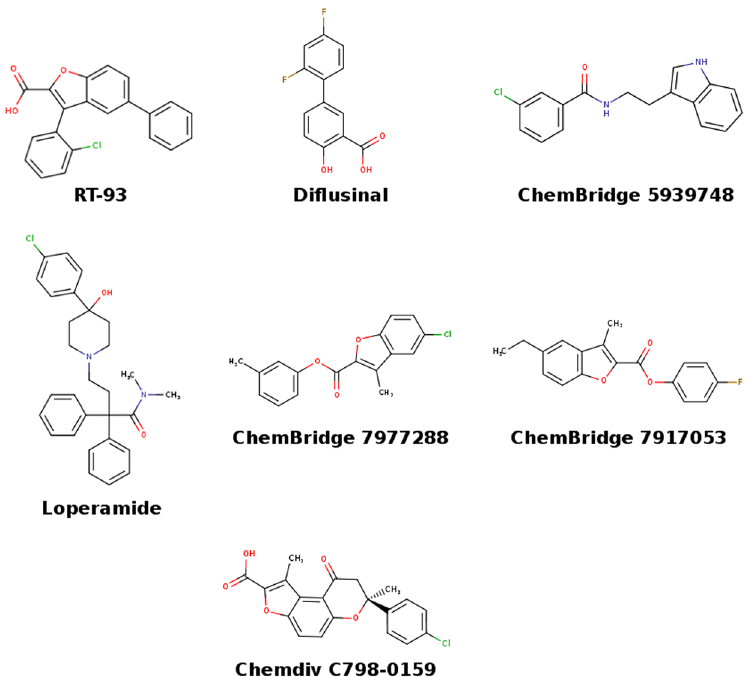
Figure 5. ClC-Kb inhibitors. The chemical structures of RT-93 and the other tested compounds with the highest current inhibition are